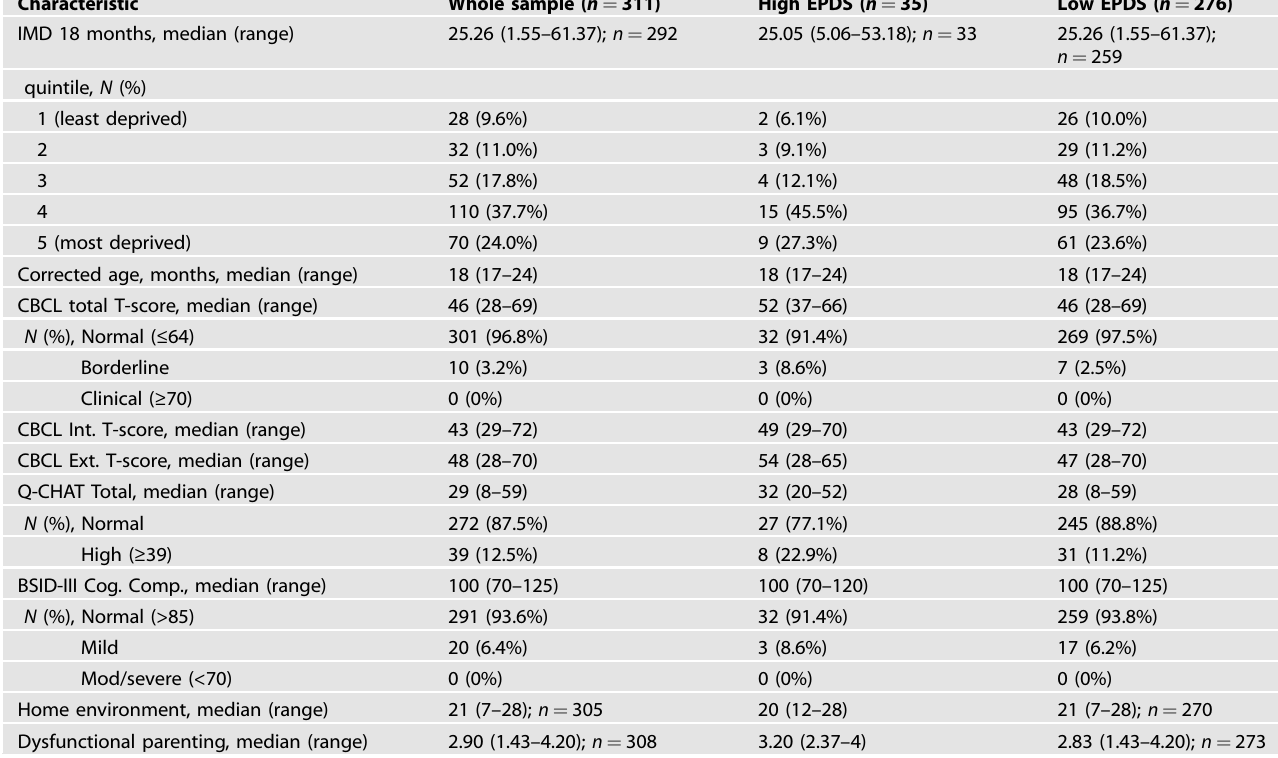
Table 2. Behavioural and cognitive outcomes in toddlers.